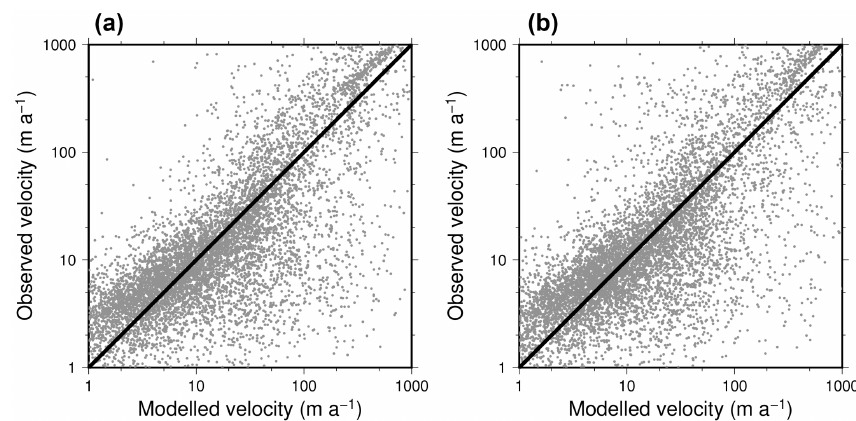
Figure 11. Observed velocity (Mouginot et al., 2017) against modelled velocity on the 40km grid. Only the best ensemble members with the lowest RMSE are shown here for Schoof (2007) (AN40S123, a ) and Tsai et al. (2015) (AN40T213, b ). The parameter values for these experiments are shown in Table 3.